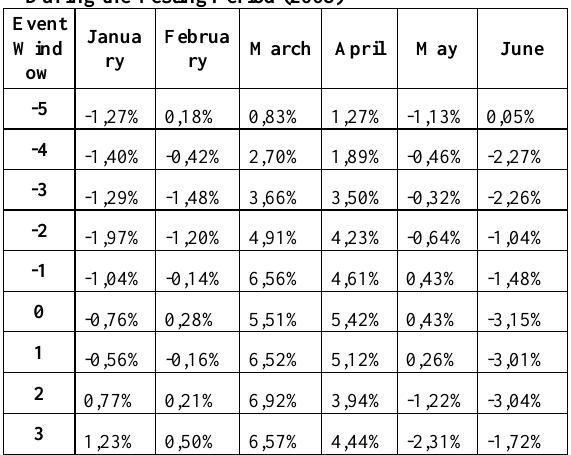
Table 2: Cumulative Abnormal Returns (CAR) During the Testing Period